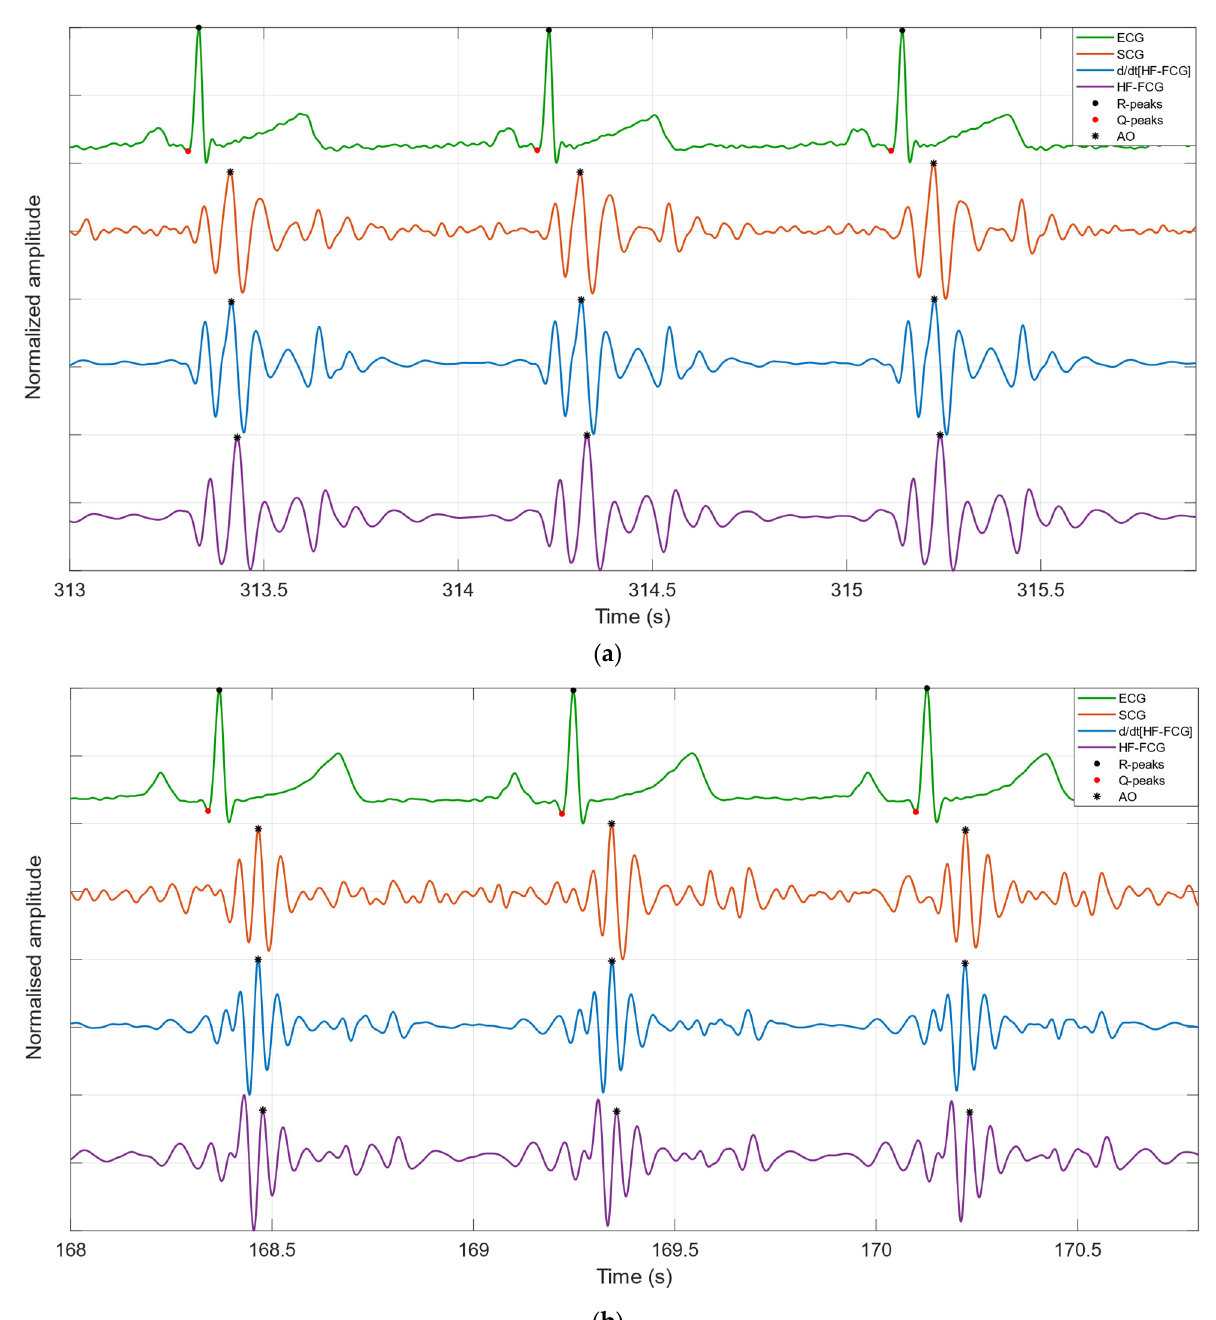
Figure 3. Examples of HF-FCG, dHF-FCG, SCG and ECG signals from ( a ) subject #1 and ( b ) subject #3.